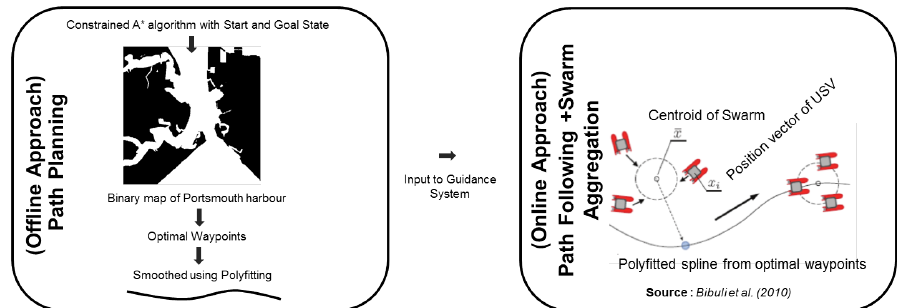
Figure 8. Schematic of integrated path planning, guidance system and swarm aggregation approach.